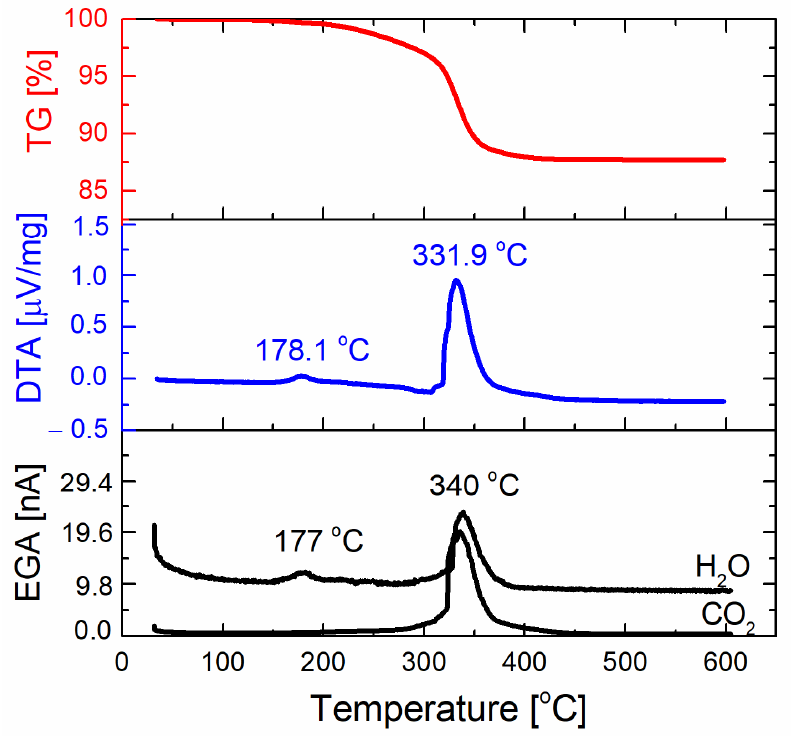
Figure 2. Thermogravimetry (TG), differential thermal analysis (DTA), and evolved-gas analysis (EGA) curves for the KNNSr/PMMA powder mixture with the volume ratio 70:30. The sintering behaviour of KNNSr was investigated using optical dilatometry. We measured the linear shrinkage as a function of temperature for the KNNSr powder compact and for the KNNSr/PMMA powder compact, with the latter preheated at 350 ◦ C (Figure